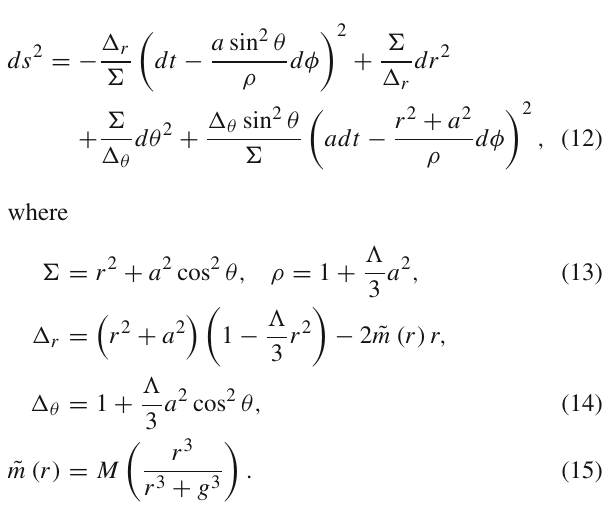
Fig. 3 Schematic diagram of black hole shadows in terms of astromet- rical observables in the celestial sphere. The figure is taken from Ref.